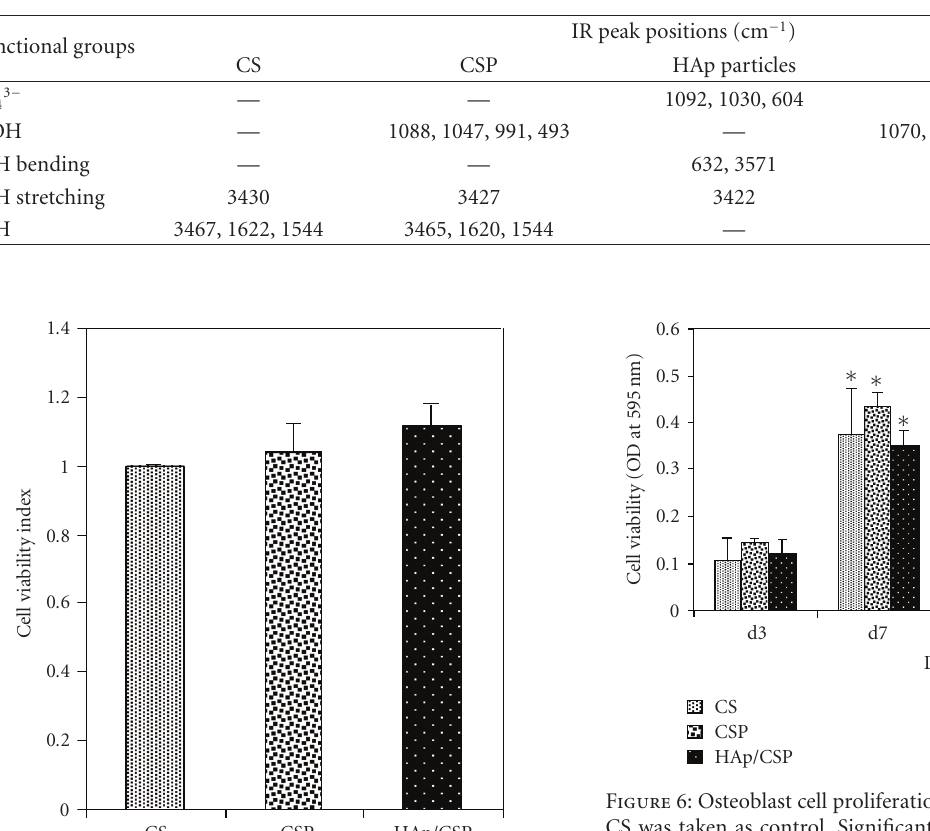
Figure 5: Cell viability test using murine fibroblast cell line L929 on CSP and HAp/CSP films, CS was taken as control ( n = 3).